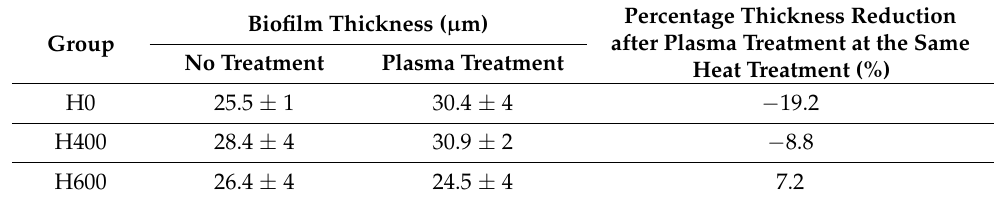
Figure 5. CLSM image of Streptococcus mutans biofilm on ( a ) H0, ( b ) H0P, ( c ) H400, ( d ) H400P, ( e ) H600, and ( f ) H600P samples. Green fluorescence indicates viable cells.